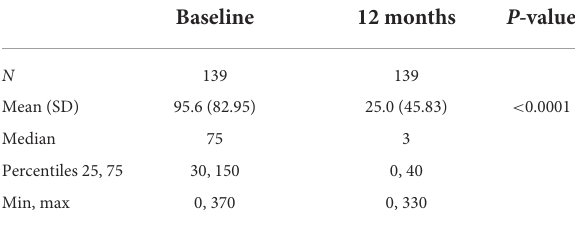
TABLE 14 Daily dose at the first visit after one year of treatment in Group 2 subjects who were administered > 80 mg/day at any 12 months P- value